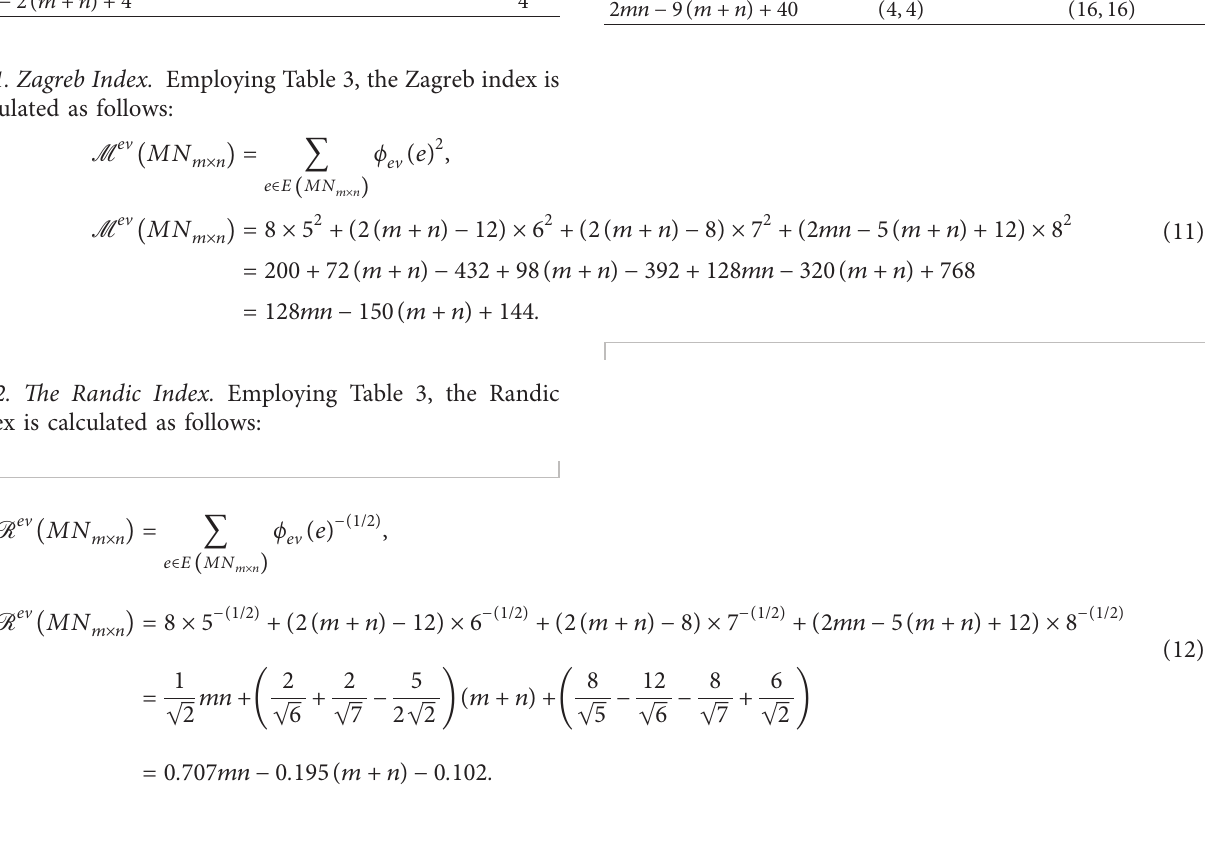
Table 2: Points partitioning of ( MN